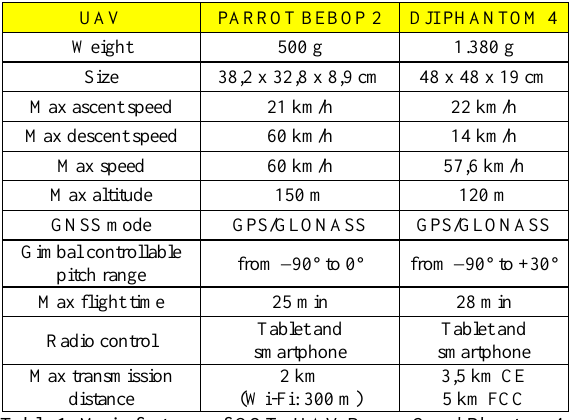
Table 1: Main features of COTs UAV Bepop 2 and Phantom 4.